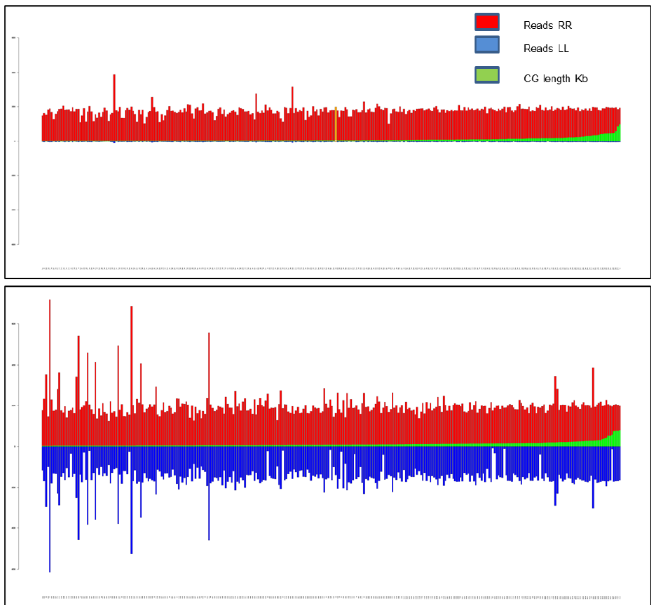
Figure 6. Graphical representation of selected contig coverage in the asm_305 assembly. Upper panel: Contigs exhibiting a ratio of mapped RR vs. SS reads of a least 30 ( log2 > 4.90) are shown. Lower panel: contigs exhibiting a ratio of RR vs. SS reads < 30 are shown. For both panels, contigs are ordered by increasing the length along the X axis. RR, SS and contig length are represented as red, blue and green bars, respectively.